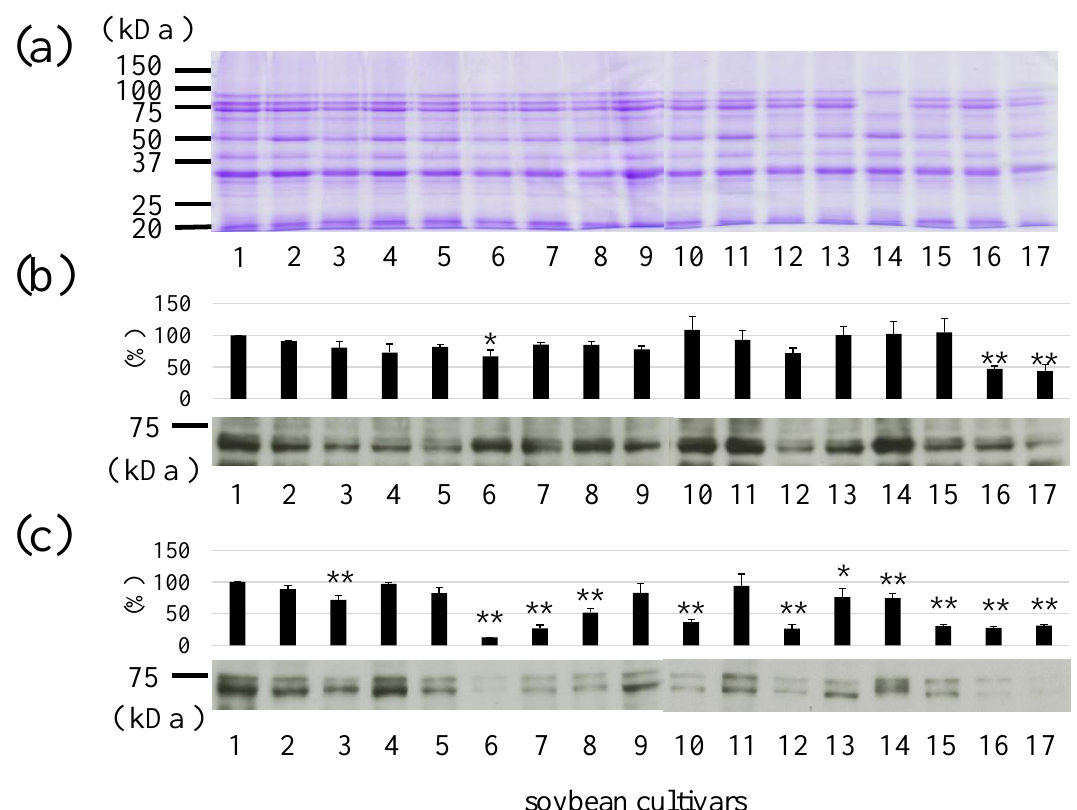
Figure 5. Relative levels of Gly m 7 allergens in various soybean cultivars (1–17). ( a ) Coomassie Brilliant Blue staining of various soybeans. ( b ) Relative Gly m 7 levels detected by anti-Gly m 7 antibody. ( c ) Relative Gly m 7 levels detected by horseradish peroxidase-labeled streptavidin. *: p < 0.05, **: p < 0.01. (samples; 1, Tachinagaha; 2, Enrei; 3, Fukuyutaka; 4, Ryuuhou; 5, Ootsuru; 6, Yukihomare; 7, Toyokomachi; 8, Toyohomare; 9, Yukisizuka; 10, Oosuzu; 11, Nanbushirome; 12, Miyagishirome; 13, Tanrei; 14, Nagomimaru; 15, Tamahukura; 16, Toyoharuka; 17, Murayutaka).